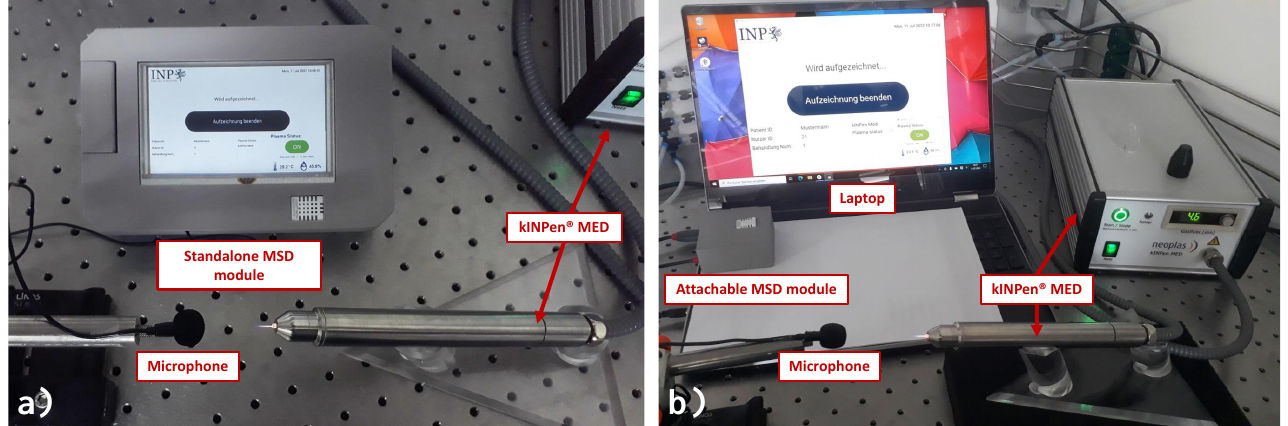
Figure 6. Assembled mobile sensory device (MSD) in use with the kINPen ® MED plasma source device. ( a ) Standalone MSD, and ( b ) MSD as an attachable module for a